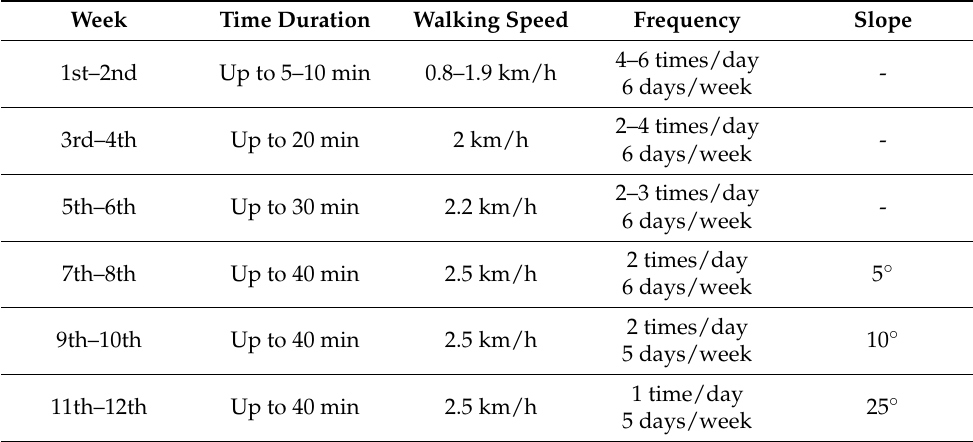
Table 2. Land treadmill locomotor training.